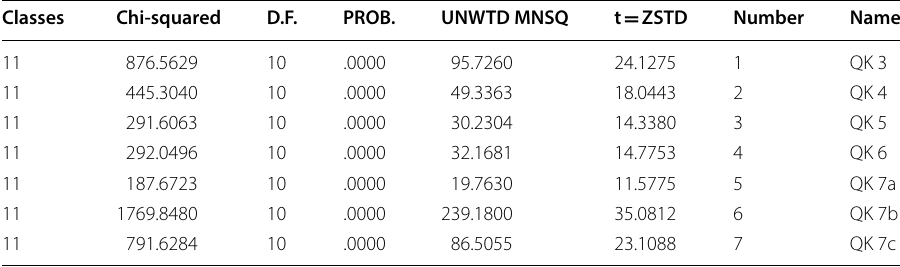
Table 7 Person summary DIF between class and group item. Source: compiled from WINSTEPS ® output (Linacre